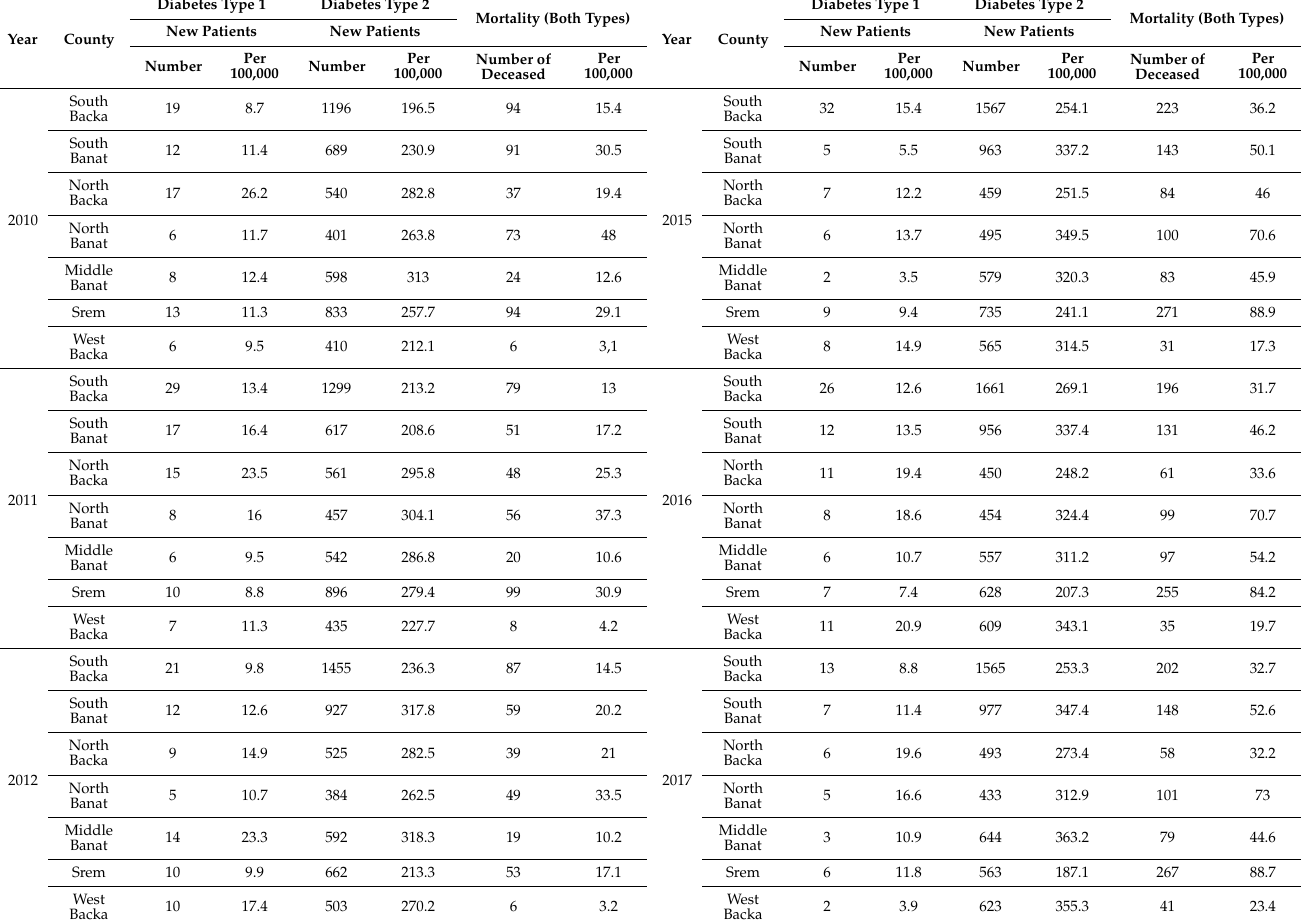
Table A3. Number of new patients suffering from type 1 and 2 diabetes, incidence rates, number of deceased, and mortality